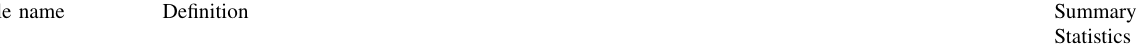
Table 1 Description of key variables in social capital, flood risk perception, and self-efficacy